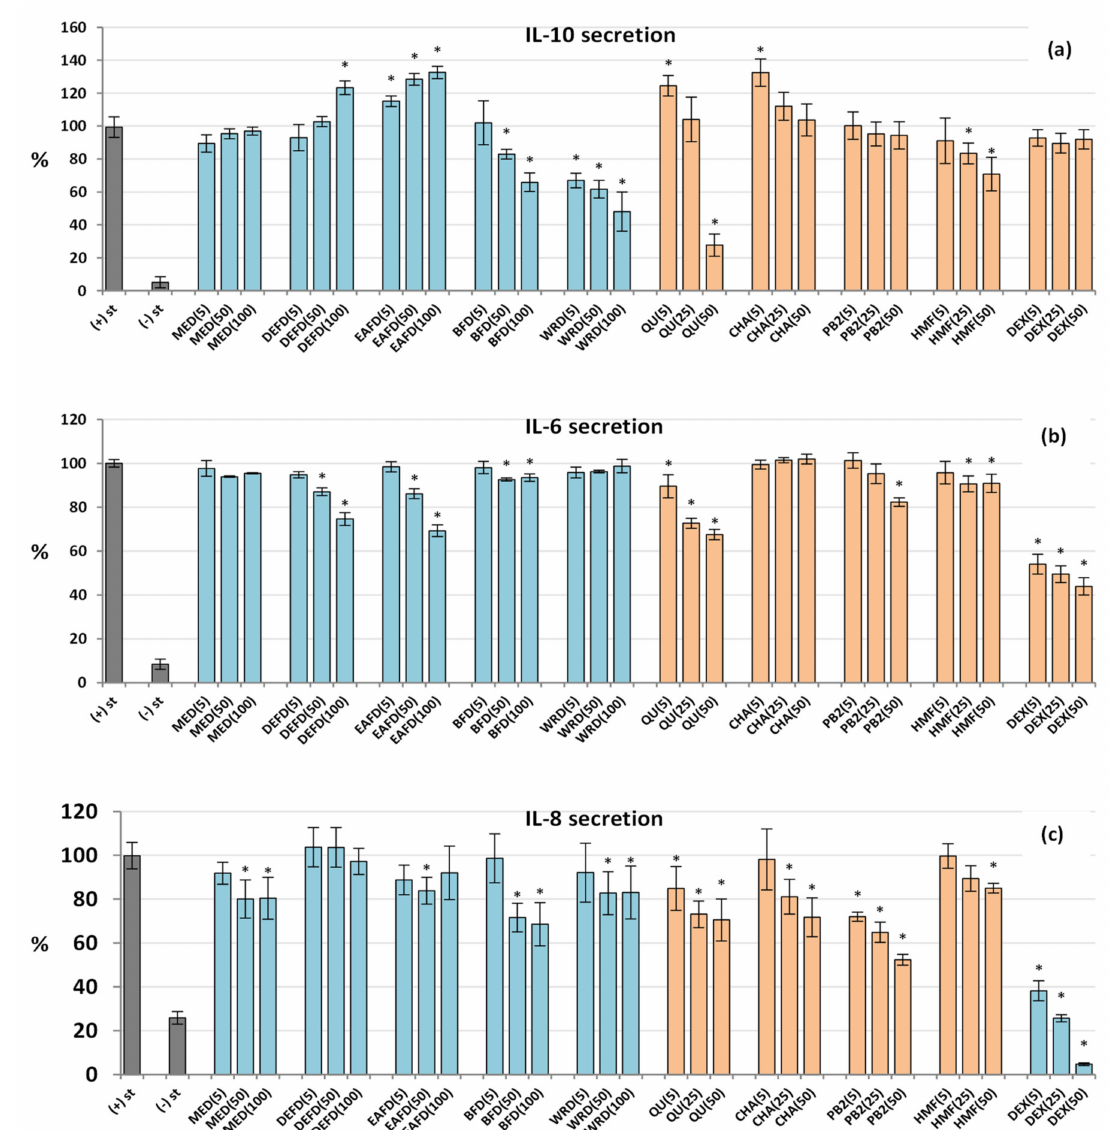
Figure 6. Effects of fruit extracts/fractions (5–100 µ g/mL) and standards (5–50 µ M) on the secretion of anti-inflammatory and pro-inflammatory interleukins from the stimulated human immune cells: ( a ) IL-10 from PBMCs; ( b ) IL-6 from PBMCs; and ( c ) IL-8 from neutrophils. Standards: QU, quercetin; CHA, chlorogenic acid; PB2, procyanidin B2; HMF, 5-Hydroxymethylfurfural. Positive control: DEX, dexamethasone. For extracts codes see Table 1. Data expressed as means ± SD of five independent experiments performed with cells isolated from five independent donors. Statistical significance in Dunnett’s test: * p < 0.05 compared with the stimulated